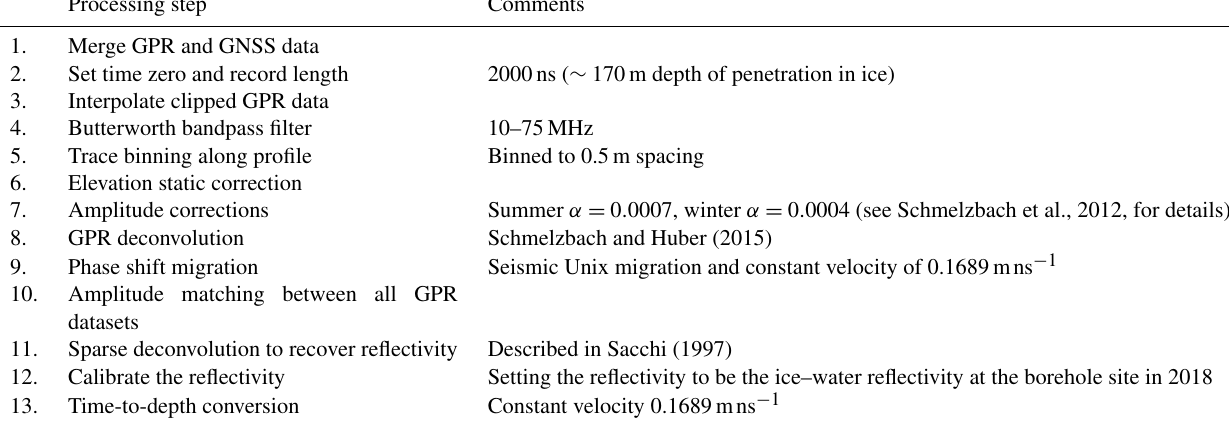
Table 2. Common offset GPR processing workflow.